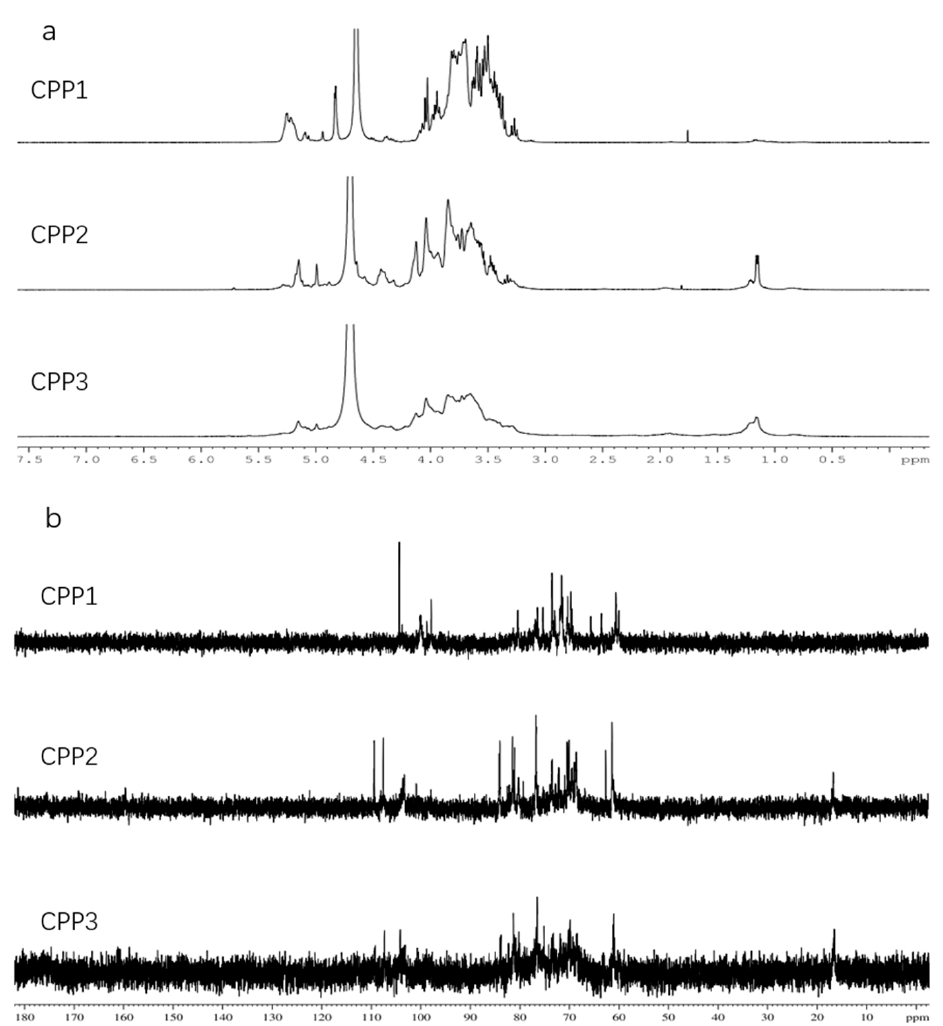
Figure 6. 1 H-NMR ( a ) and 13 C-NMR ( b ) spectra of CPPs.